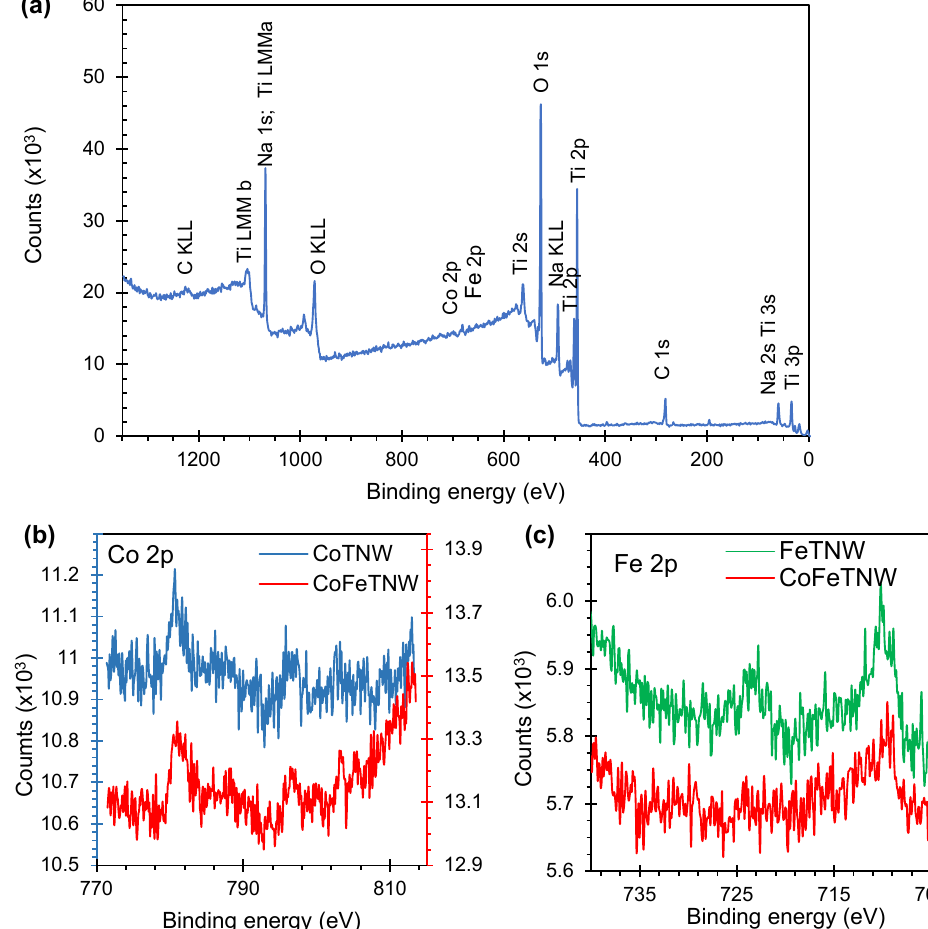
Figure 2. ( a ) XPS survey spectrum of the CoFeTNW sample. XPS high resolution spectra of the Co 2 p ( b ) and Fe 2 p ( c ) regions of the prepared samples.